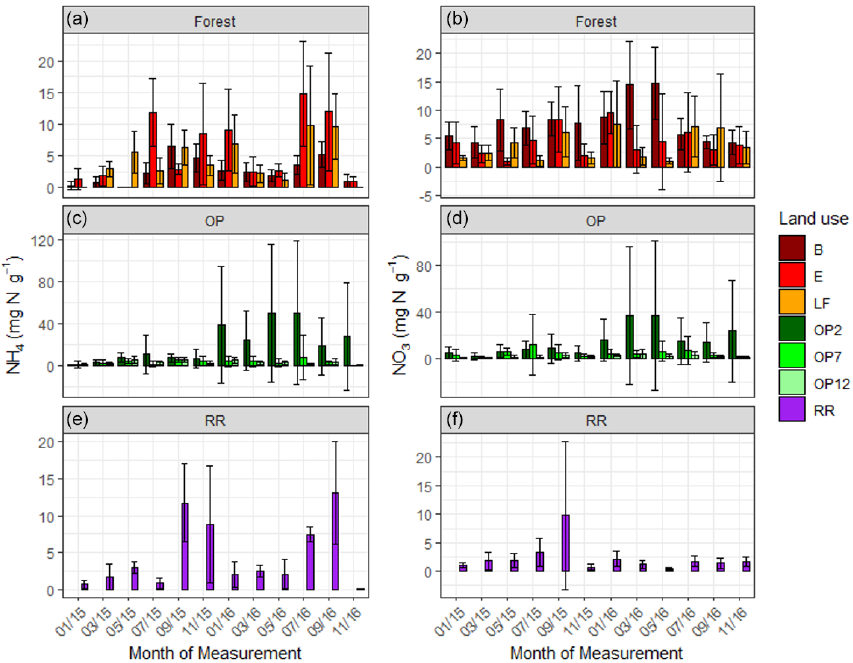
Figure 3. Mean mineral N as KCl-extractable NH + logged forests; c, d OP2, OP7, OP12: oil palm plantations; e, f RR: riparian reserve). Error bars represent standard deviation of the samples around the mean. Please note the different y -axis scale for